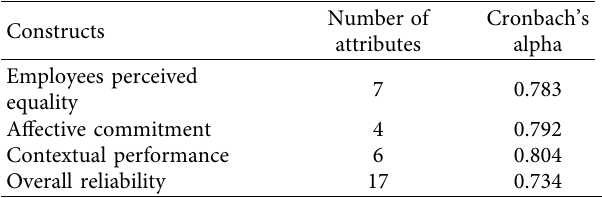
Table 2: Reliability statistics.